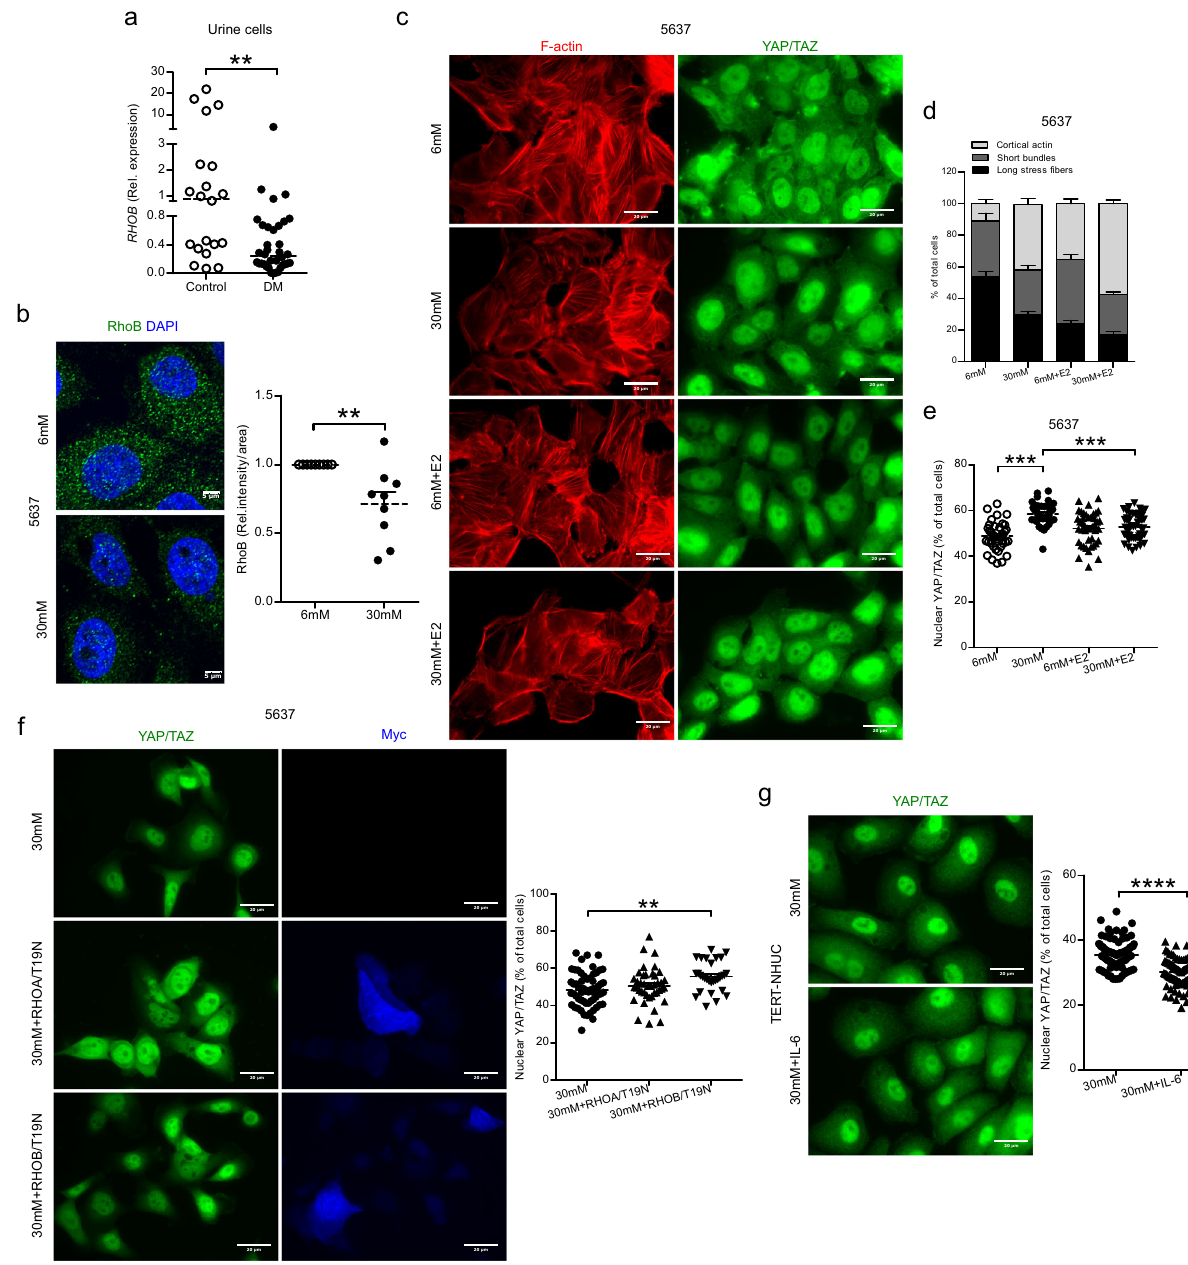
Fig. 5 | High glucose alters the RhoB expression and translocate YAP/TAZ. a Expression of RHOB mRNA in urine cells from non-diabetic ( n =20) and diabetic patients,DM( n =36)(unpairedtwo-tailedttest, p =0.0032). b Microscopyanalysis of RhoB was measured in 5637, uroepithelial cells after treatment with glucose (normal=6mM: high=30mM) for 36h ( n =9) (Mann-Whitney two-tailed test, p =0.0035). c 5637 treated with high glucose and estrogen (Estradiol, E2, 10nM) for 48h. F-actin fi laments and YAP/TAZ were visualized in both normal and high glucose treated cells (6mM, n =190; 30mM, n =164; 6mM+E2, n =189; 30mM +E2, n =194),representativeimagesareshown. d Quantitativeanalysisofcellswith cortical actin, short bundles and long stress fi bers is presented (6mM, n =190; 30mM, n =164; 6mM+E2, n =189; 30mM+E2, n =194) (One-way ANOVA,